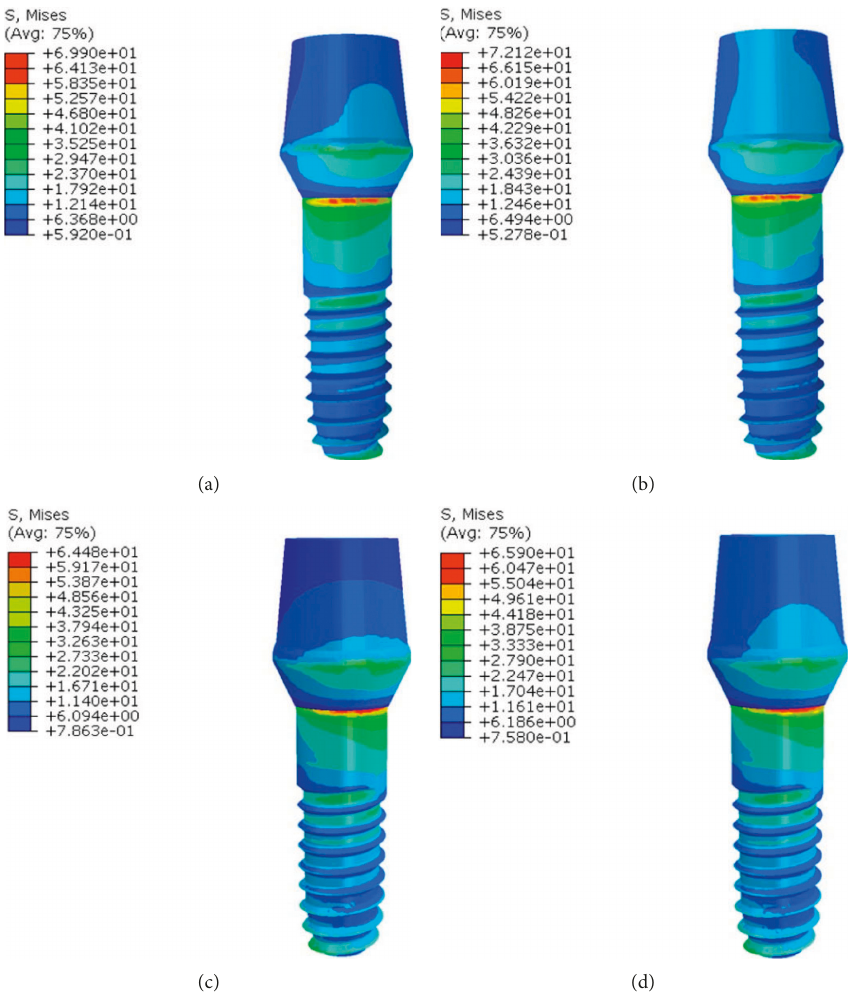
Figure 4: Stress distribution in abutments in model 1. (a), (c) PFBM; (b), (d) PFNM.